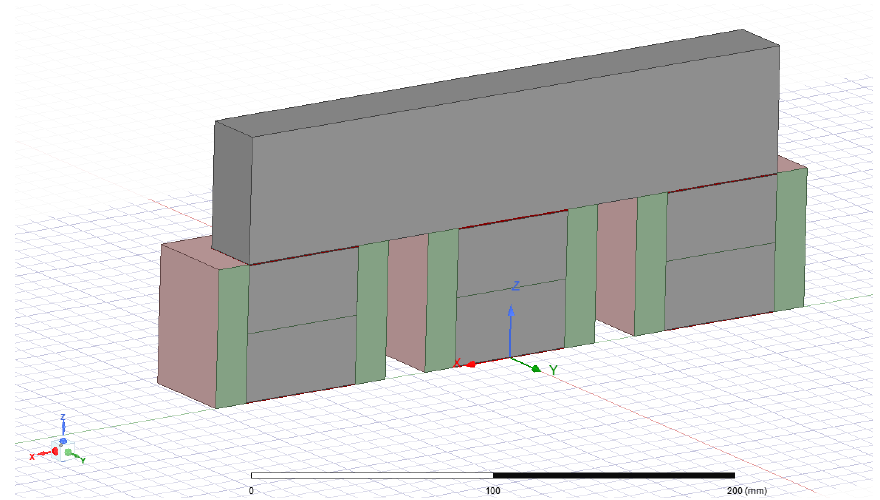
Figure 7. Testing geometry of three-phase compensation choke (quarter symmetry used). The core was fabricated by Power Core ® H 075-23L with BH and specific losses curves at 50 Hz, as shown in Figures 8 and